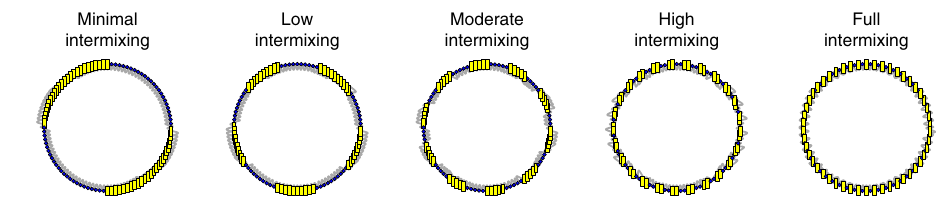
Fig. 2 Intermixing of diverse abilities. Intermixing distributions of A and B agents in networks for the diversity of